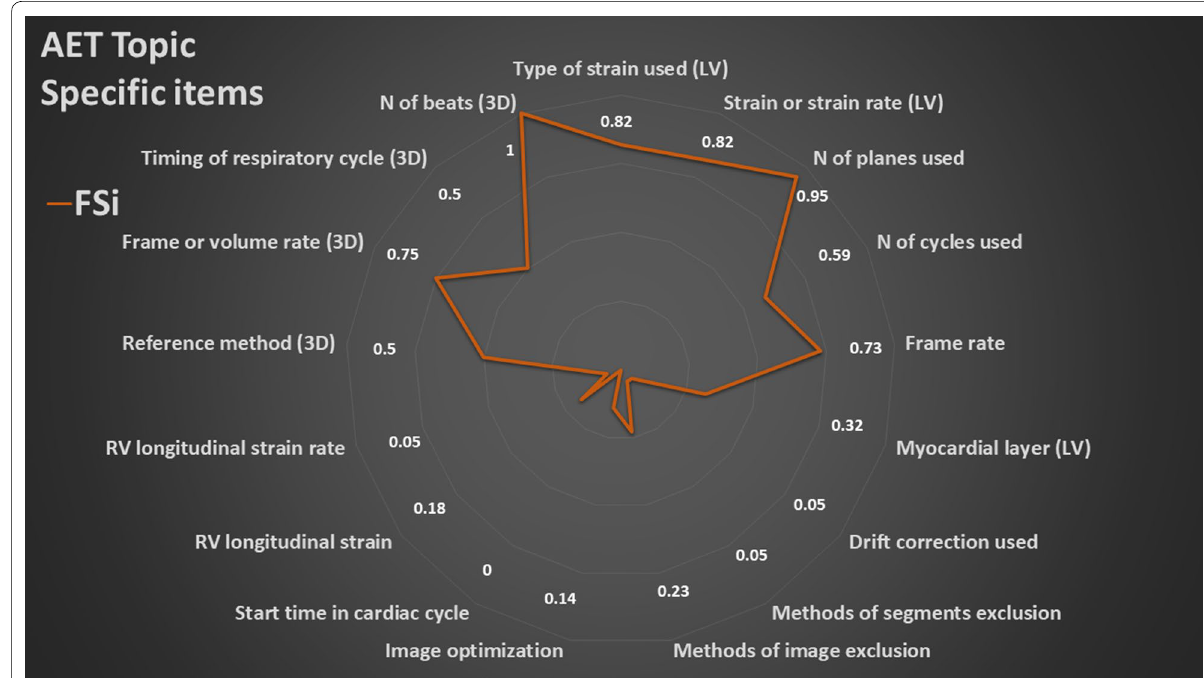
Fig. 7 Radar plot of the fraction of studies reporting an item (FSi) in the advanced echocardiography techniques (AET) topic. All parameters but the last four in anticlockwise sense starting at 12 o’clock refers to strain echocardiography method. The last four refers to three‑dimensional echocardiography (3‑D) method. LV: left ventricle, RV: right ventricle. As example, an FSi score of 0.82 for type of strain used for LV studies means that 82% of studies reported the type of strain used to evaluate LV